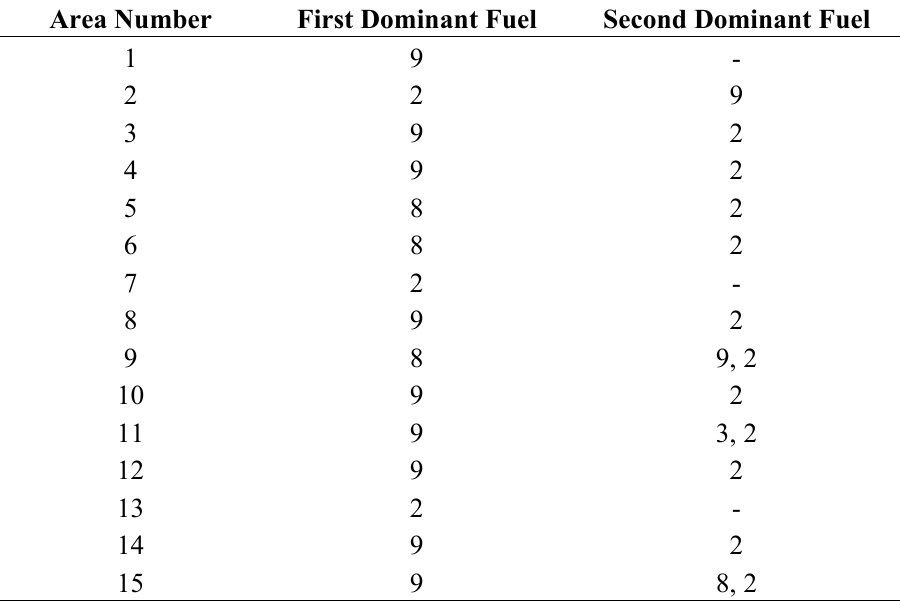
Table 2. Dominant fuel models in each